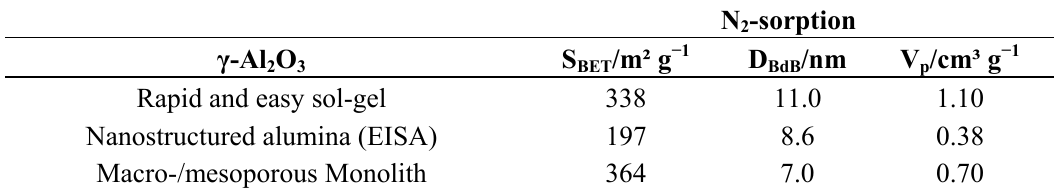
Table 2. Comparison of the textural properties of the mesoporous alumina ( γ -Al prepared by different